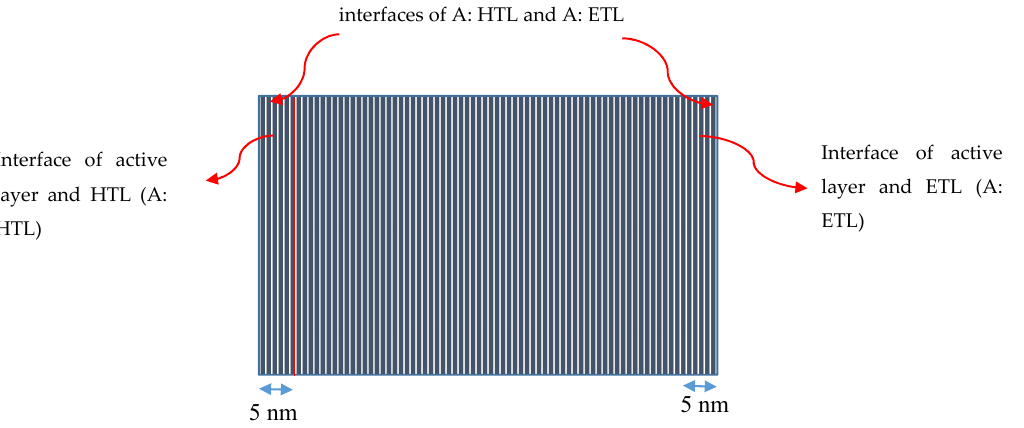
Figure 1. Schematic of heat transfer mechanisms in an illuminated solar cell: yellow arrows show incident solar power, orange arrow represents heat generation due to non-radiative recombination, blue arrows represent heat loss to the ambient air due to convection and black arrows represent heat loss due to radiation.